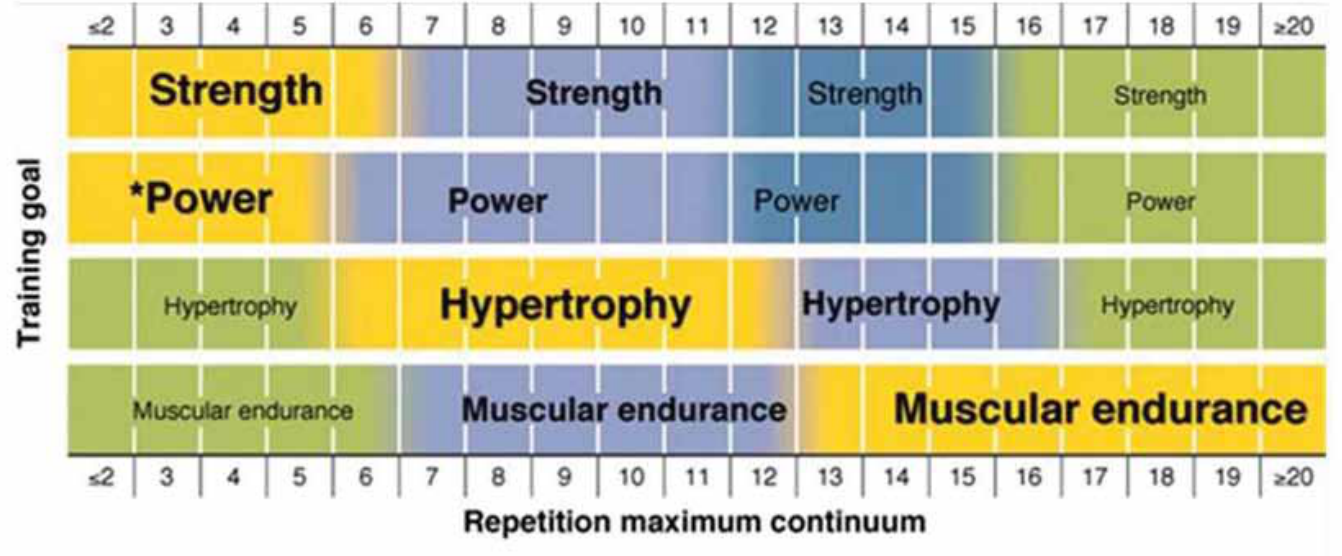
Figure 2-3. Repetition Ranges for Specific Training Outcomes sprint drills, bounding activities, or jumping, follow the dynamic stretching. The more power necessary for the sport or activity, the more important the warm-up becomes. Including high-intensity dynamic exercises can facilitate subsequent performance. This phase should also include rehearsal of the skills to be